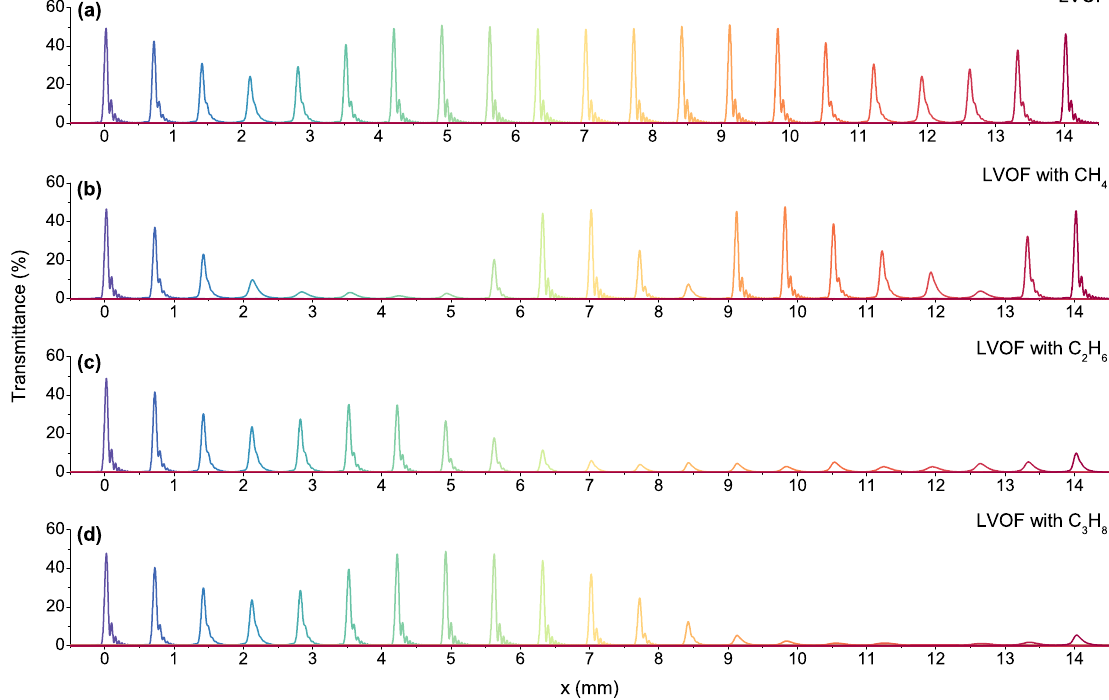
Figure 3. Simulated wideband spectral response of ( a ) the LVOF; ( b ) LVOF with methane; ( c ) LVOF with ethane and ( d ) LVOF with